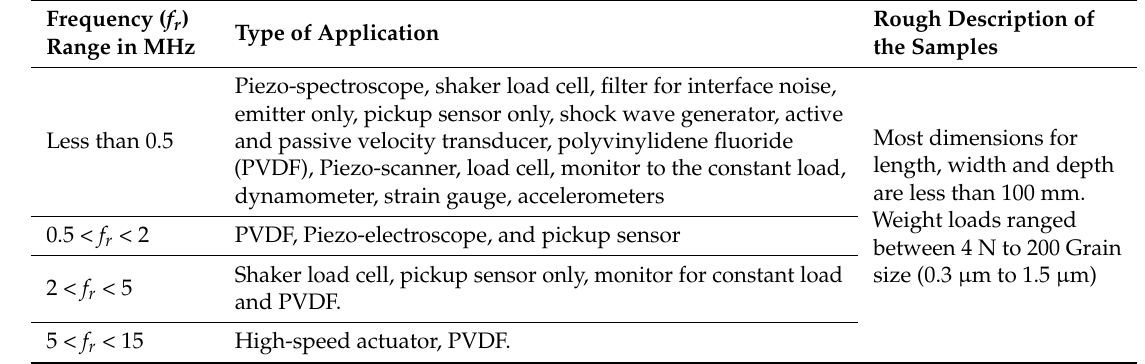
Table 3. Types of applications for PE according to frequency